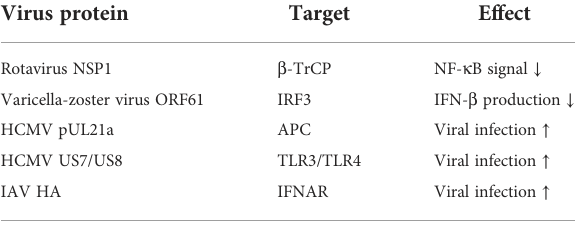
TABLE 1 Substrate molecular simulation. Virus protein